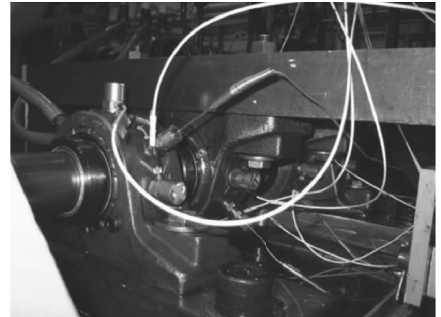
Figure 21: Bearing test rig of